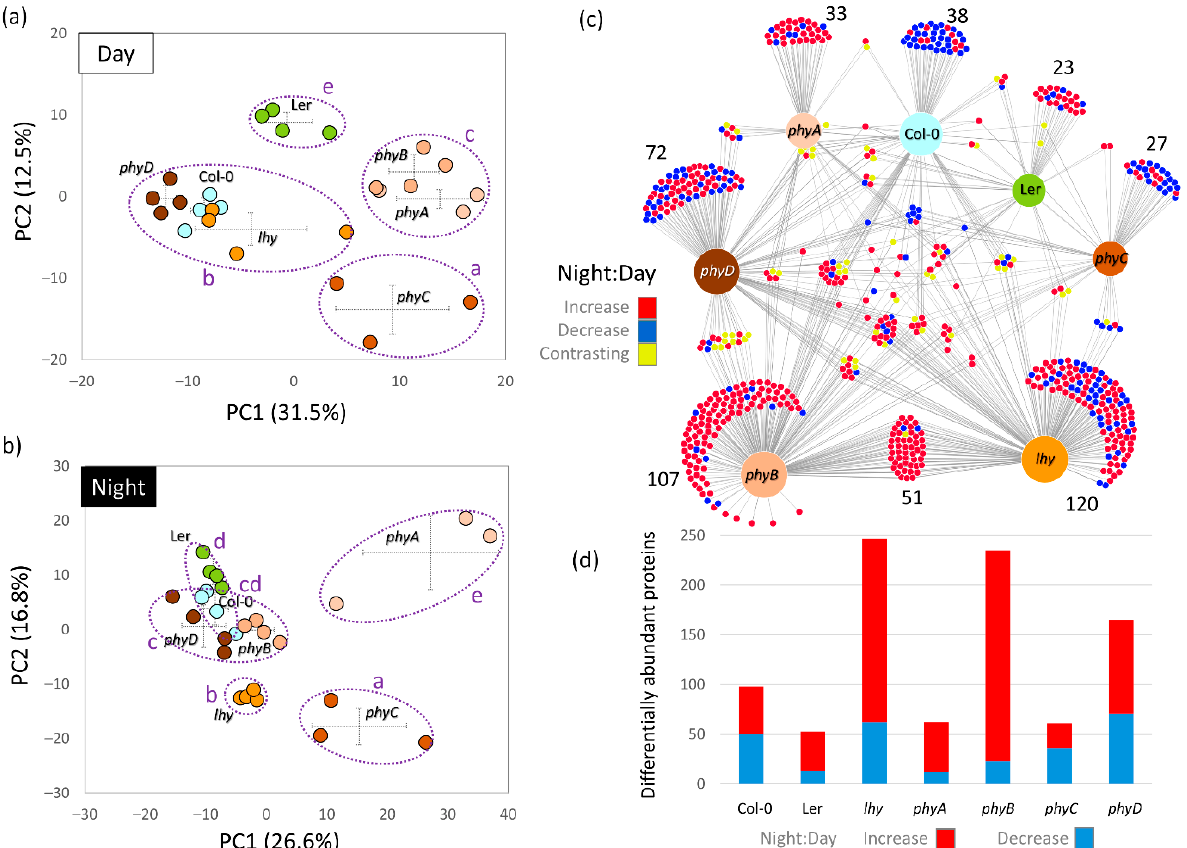
Figure 3. Night–day differences in proteomes of collected plantlets. ( a , b ) The principal component analysis (PCA) based on the profile of 315 and 650 differentially abundant proteins found in plantlets collected in the middle of the light and dark periods, respectively (ANOVA, p < 0.05, at least 1.5-fold change); ( c ) Comparison of the responses to light visualized with DiVenn 2.0; ( d ) Light-responsive differentially abundant proteins found in all genotypes. The results are based on at least three biological replicates. The letters in panels ( a , b ) indicate statistically significant differences (Kruskal–Wallis test, p < 0.05).